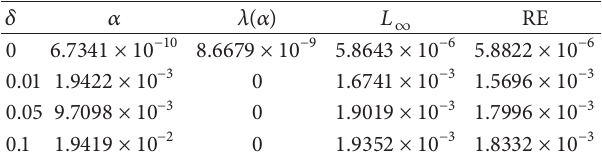
Table 1: 𝑇 = 0.1 , the objective function 𝜆(𝛼) , the 𝐿 ∞ , and the relative errors for 𝑓(𝑥) , with 𝛿 = 0,0.01, 0.05, 0.1 .